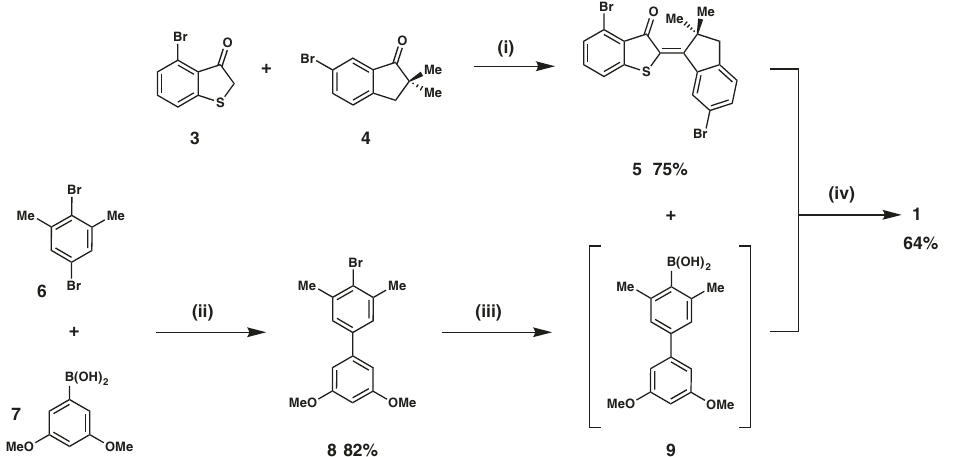
Fig. 2 Synthesis of tweezers 1 via a convergent route. (i) BCl 3 , THF, 0 °C, 20 min. (ii) K 2 CO 3 , Pd(PPh 3 ) 4 , 1,2-dimethoxyethane, H 2 O, 84 °C, 13 h. (iii) First sec -BuLi, THF, − 78 °C, 30 min, then B(OMe) – 78 °C, 15 min, then 23 °C, 30 min, then HCl acidic workup. (iv) sSPhos Pd G2, K 3 ,